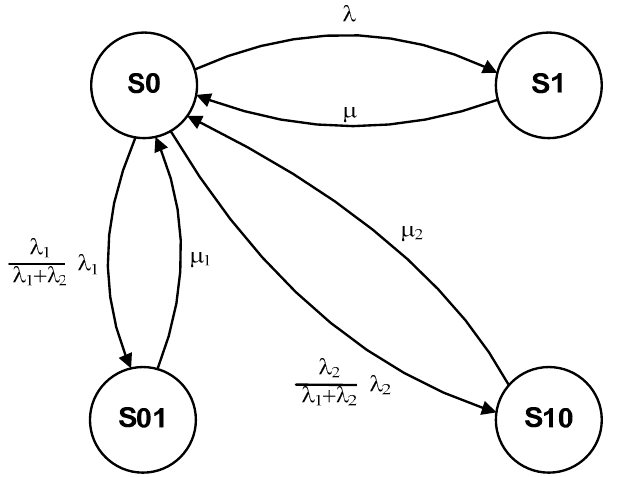
Figure 3. Diagram of the operation process of a Wind Equipment Farm not equipped with any intelligent expert systems SERV.